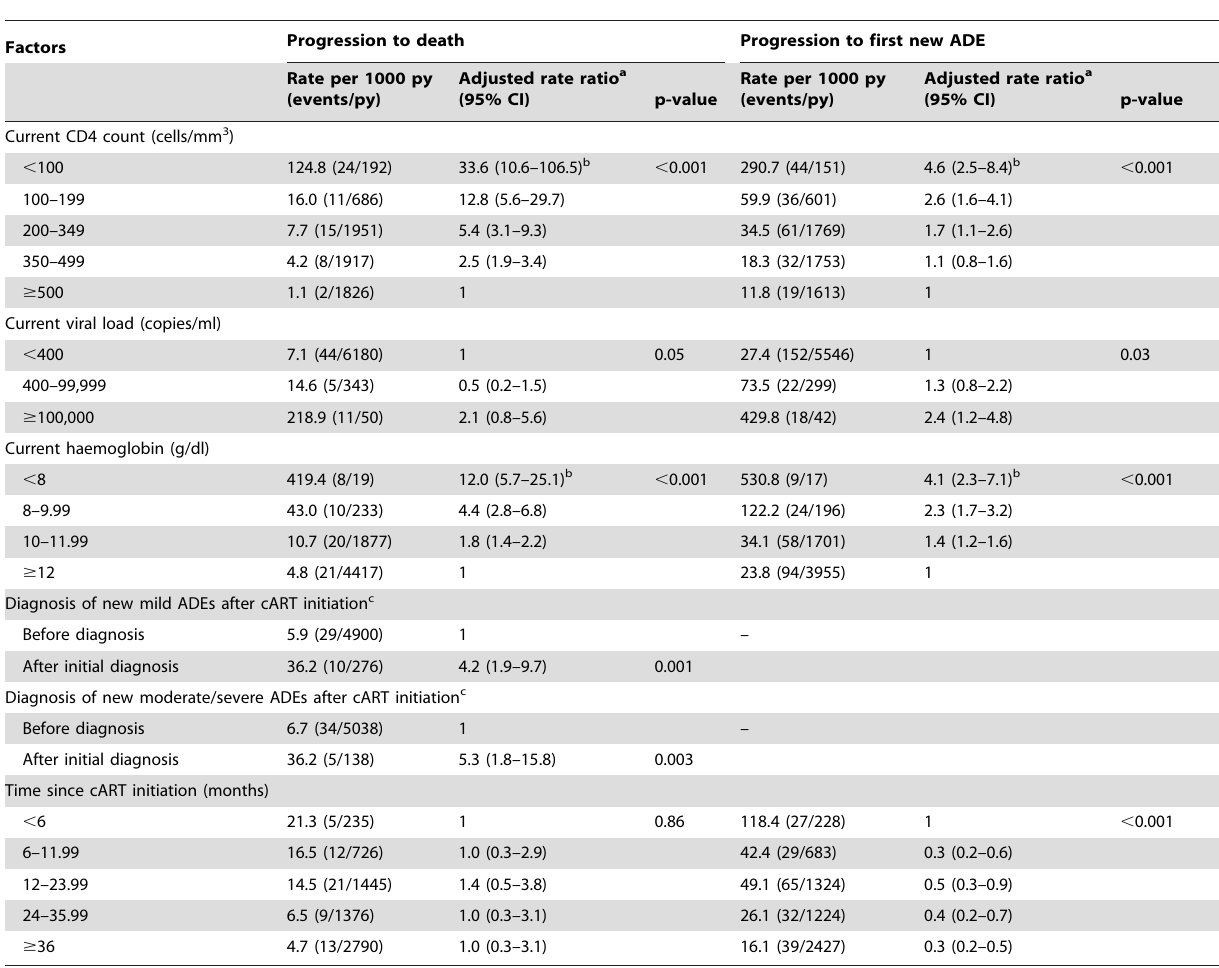
Table 3. Predictive effects of factors after cART initiation on progression to death and to new ADE.